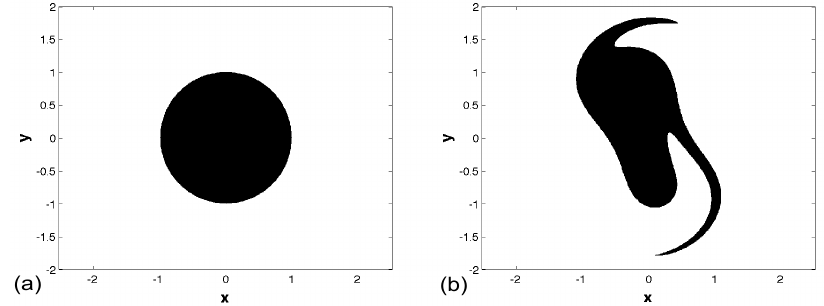
Figure 10. Evolution of a vorticity patch. (a) Initial vorticity distribution at time t = 0; (b) evolution of the vorticity at time t = 2.